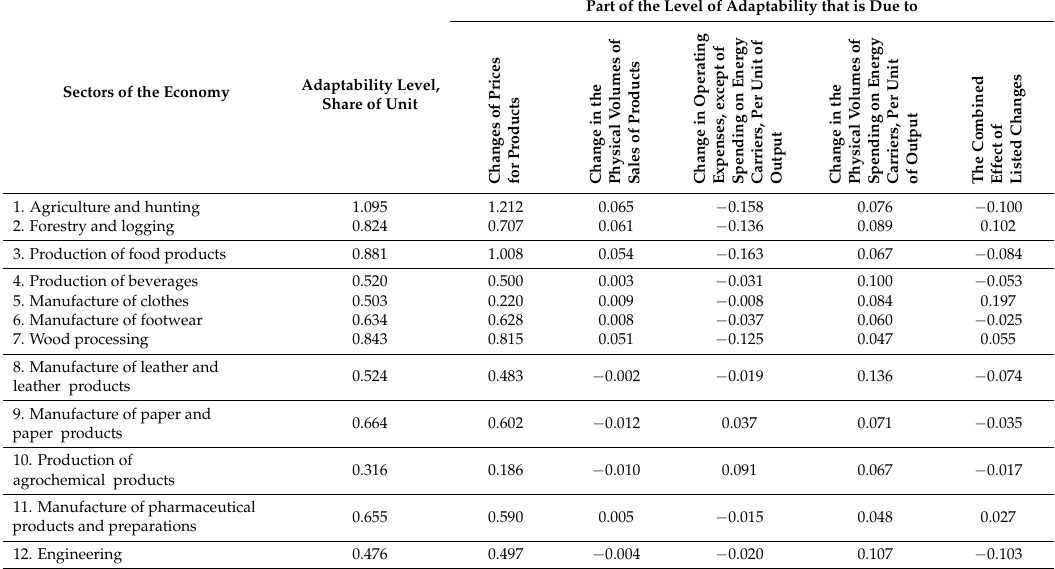
Table 2. The results of the decomposition of the level of adaptability of the sectors of the Ukrainian economy to the rise of prices for energy carriers in 2015 comparatively with 2014. Part of the Level of Adaptability that is Due